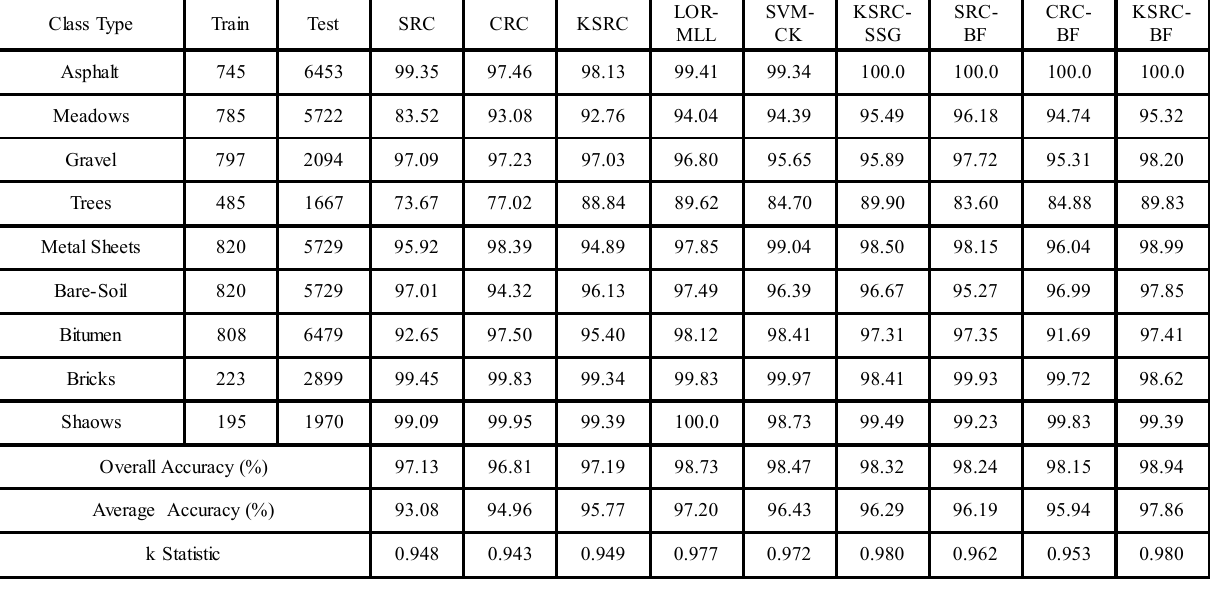
TABLE 4. CLASSIFICATION ACCURACY (%) FOR THE CENTRE OF PAIVA IMAGE USING THE 5% LABELED